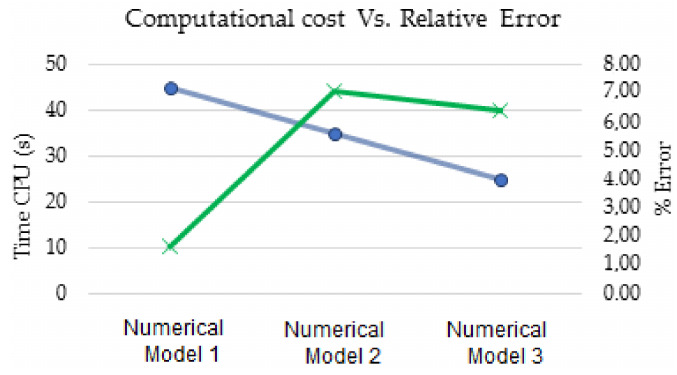
Figure 8. Computational cost vs. relative error.